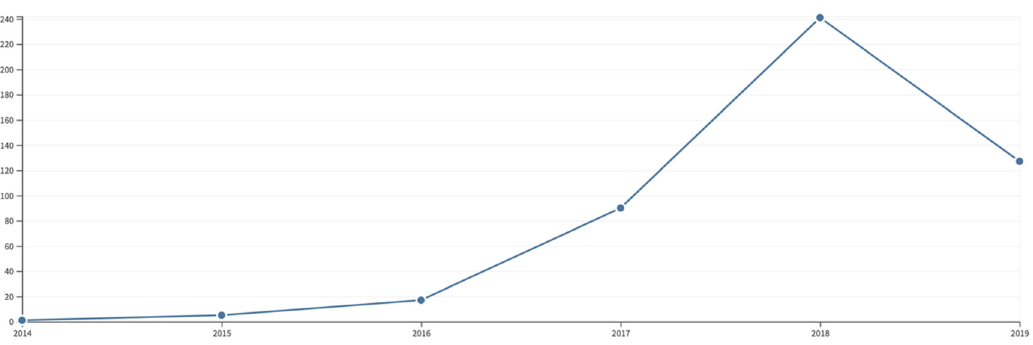
Figure 5. Sum of times cited per year of “Industry 4.0” OR “Industrial revolution 4.0” AND TOPIC “construction” OR “building” keyword from 2014 to 2019 in Web of Science.